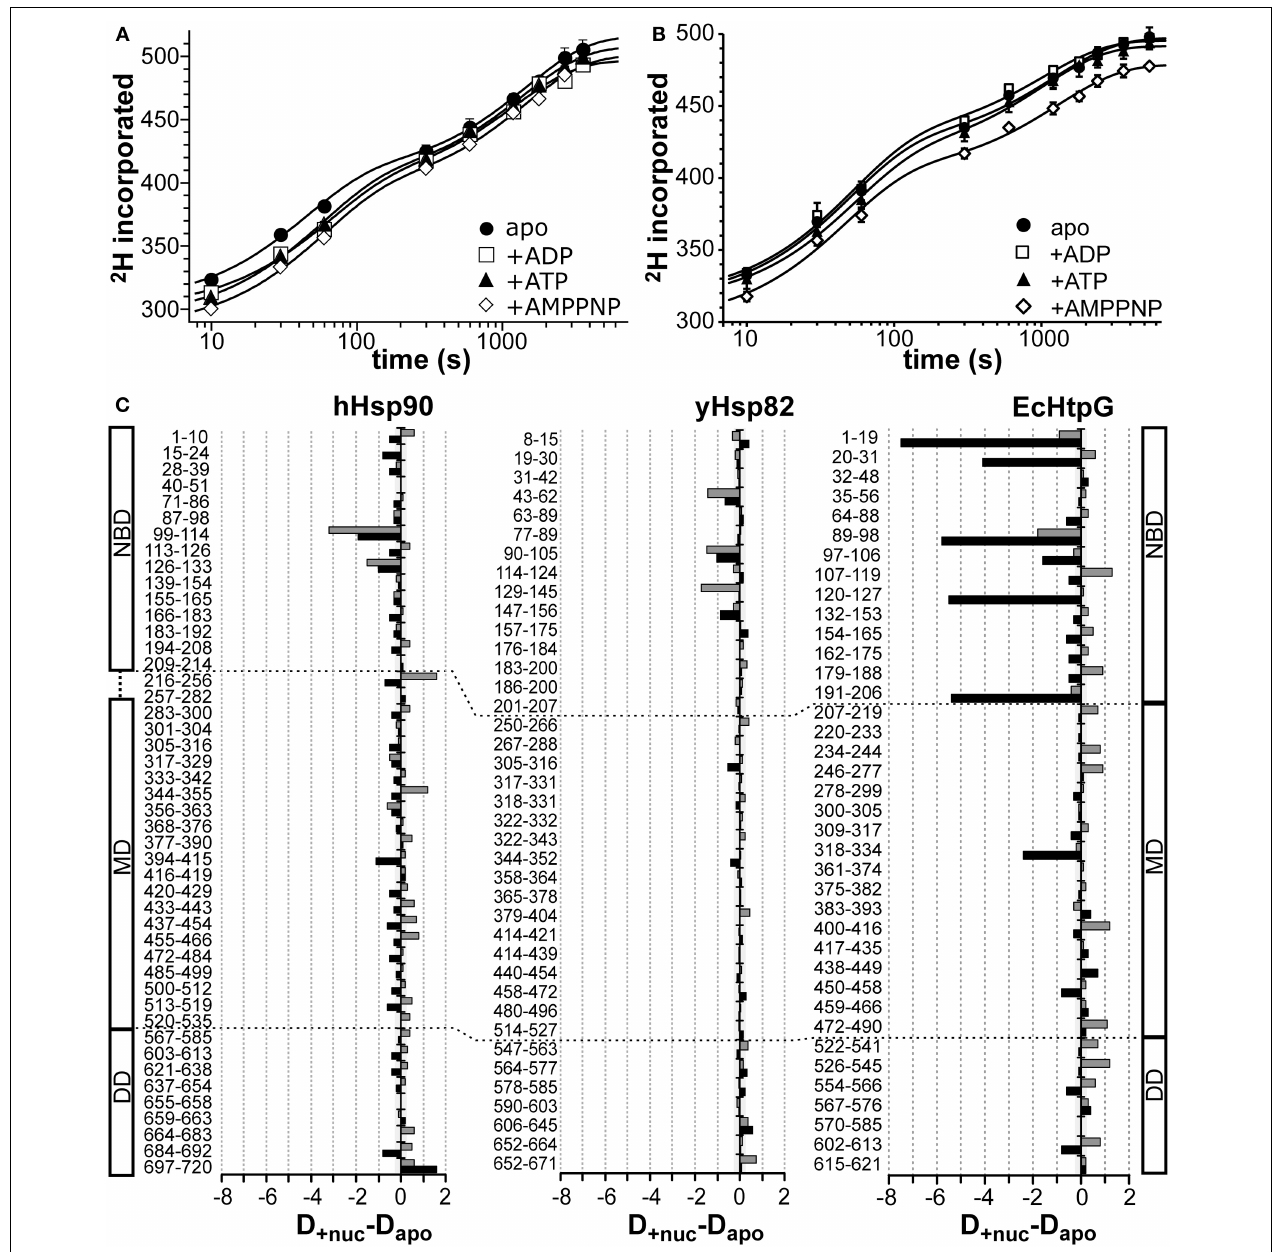
FIGURE 4 | Nucleotide dependent changes in the HX kinetics of Hsp90 proteins. Deuteron incorporation into full-length hHsp90 (A) and yHsp82 (B) in the absence of nucleotides (black circles) and in the presence of ADP (open squares), ATP (black triangles), and AMPPNP (open diamonds). The solid lines are fits of a bi-exponential equation to the data. (C) Difference plots of deuterons incorporated in the presence of ATP (black bars) and ADP (gray bars)